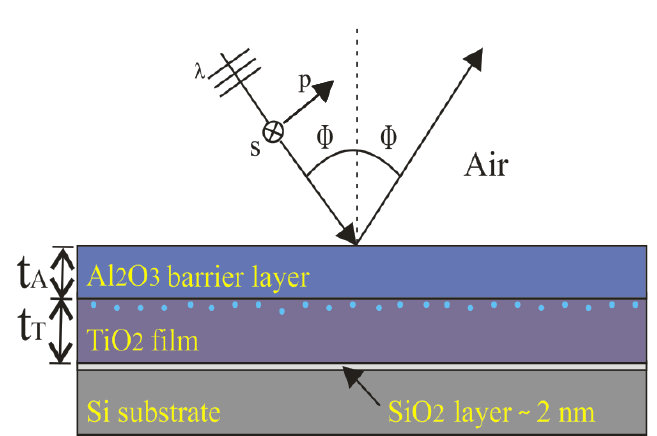
Figure 1. Schematic diagram of a TiO layer deposition (ALD) on a Si substrate. The illumination geometry in ellipsometric measurements is also